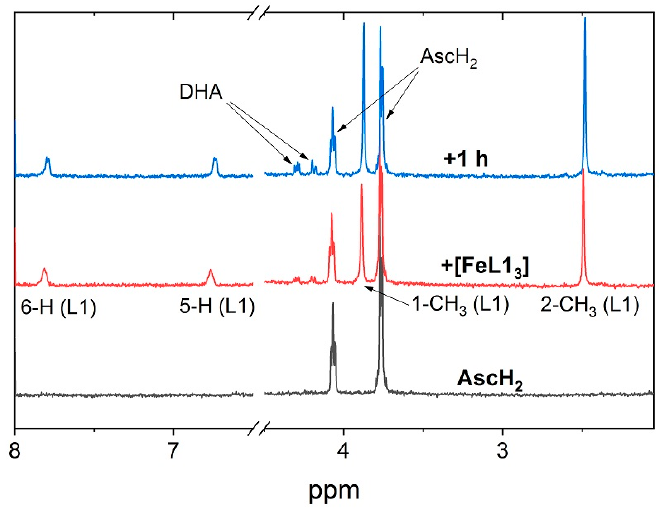
Figure 3. Fragments of the 1 H NMR spectra of 0.4 mM of ascorbic acid in D 2 O at pH = 4.1 in the absence and in the presence of 0.1 mM of FeL1 3 complex just after mixing and after one-hour storage at room temperature.